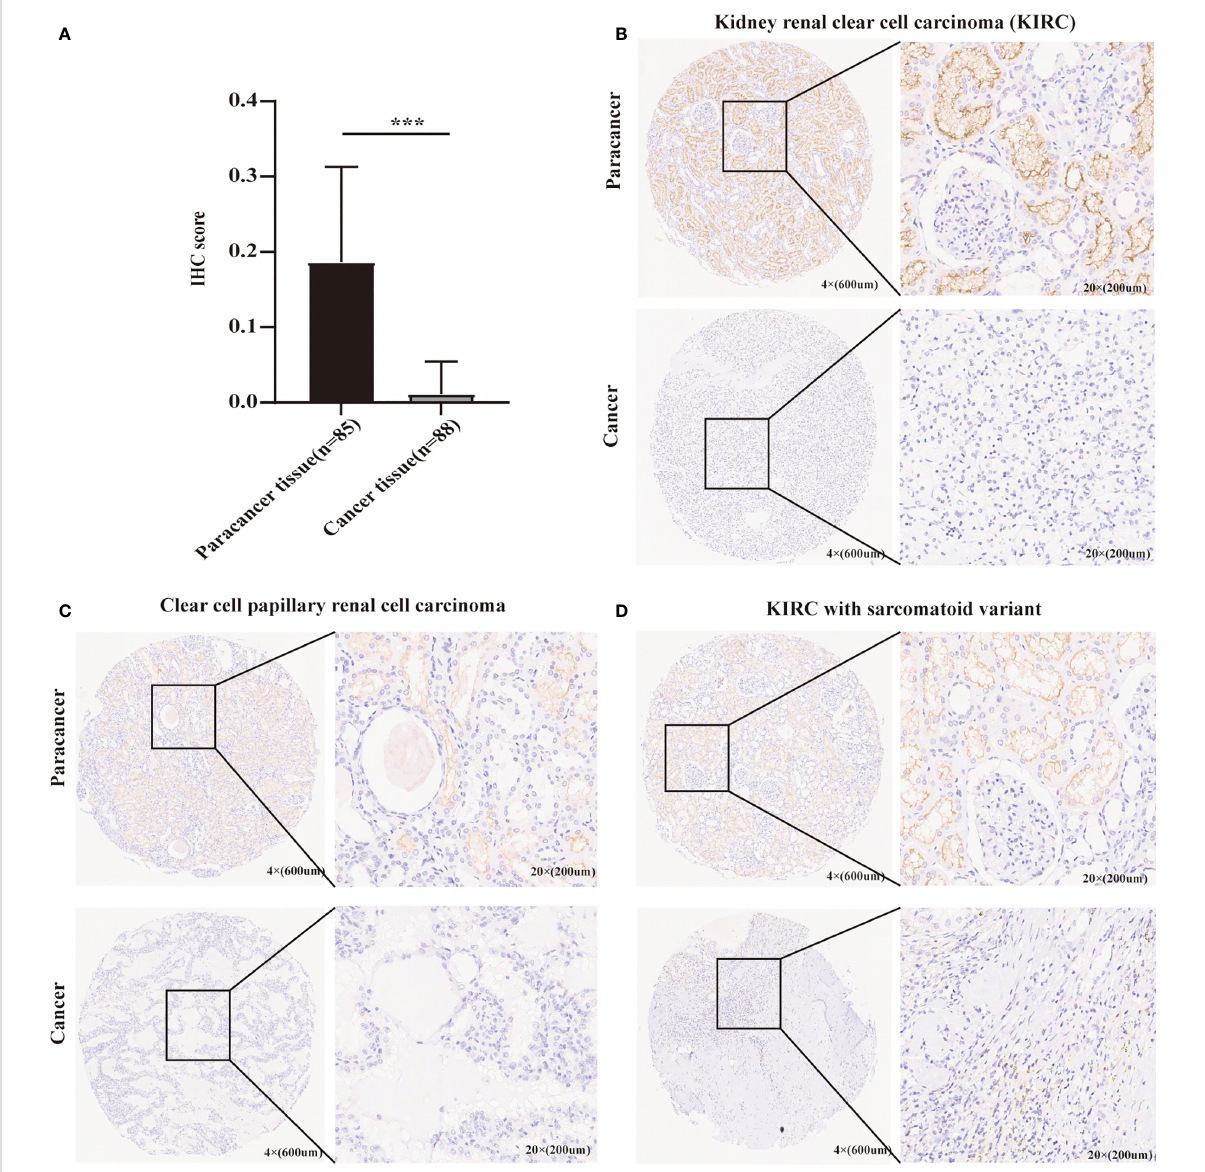
FIGURE 2 The veri fi cation of METTL24 expression in KIRC tissues and normal adjacent tissues using our self-built Chinese cohort. (A) The protein level of METTL24 was signi fi cantly decreased in KIRC tissues compared with normal adjacent tissues (n tumor = 88, n normal = 85); T-test was used for the statistical analysis. (B-D) Representative images of METTL24 expression in KIRC tissues and paracancerous tissues. The immunohistochemical assay was performed for detecting METTL24 expression. ***p <